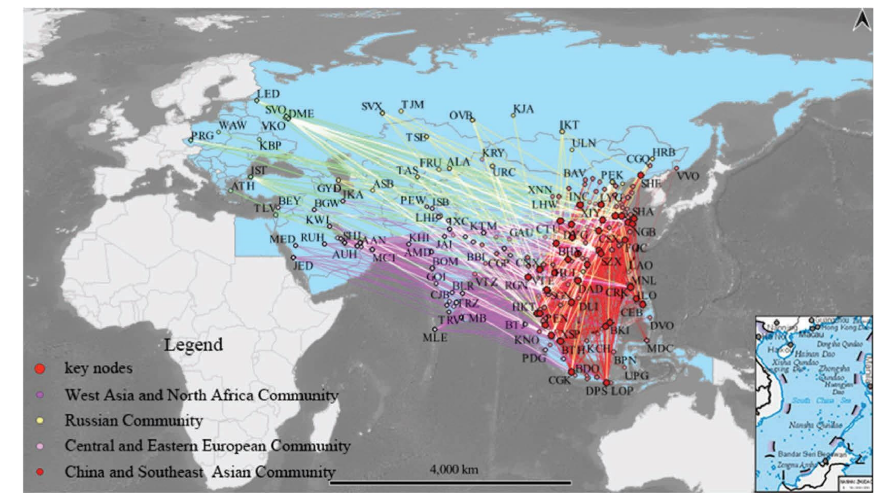
Figure 12: International routes of key node set in China and Southeast Asian